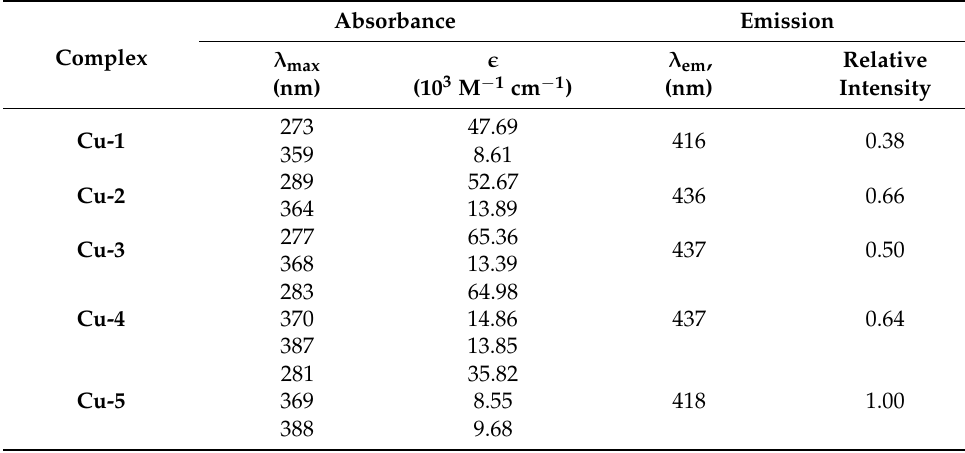
Figure 5. Overlaid absorption (left) and emission (right) spectra of complexes Cu-1 – Cu-5 . Table 1. Spectroscopic Data of Complexes Cu-1 – Cu-5